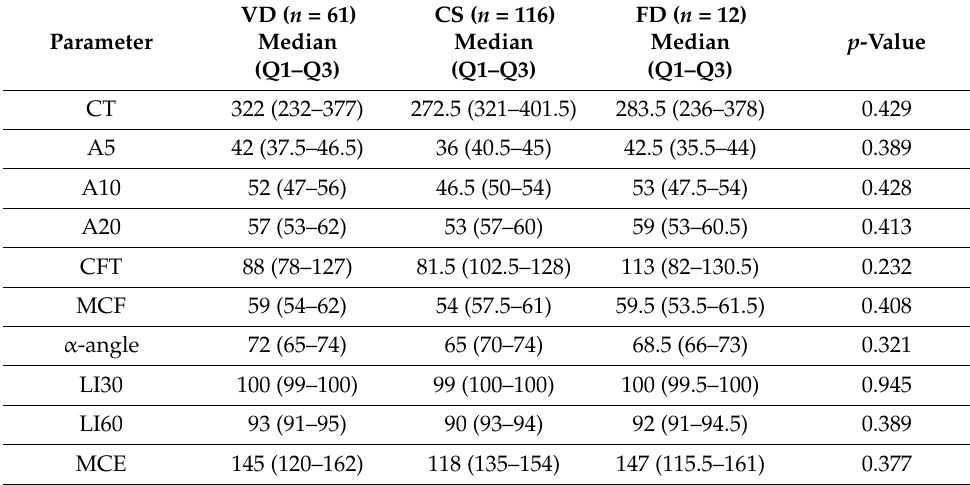
Table 4. NATEM parameters and delivery mode.